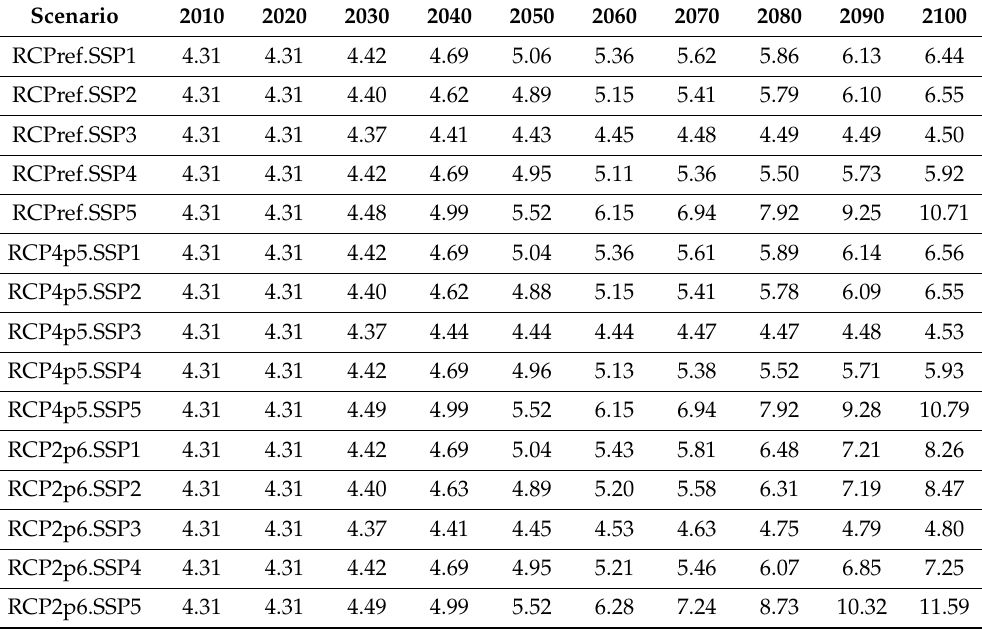
Table A22. Industrial roundwood harvest assortments—Sawlogs (millions of m 3 / year, under bark). Scenario